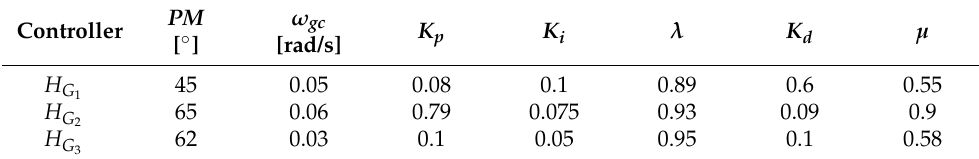
Table 3. The imposed performances and the resulting FO-PID controller parameters.